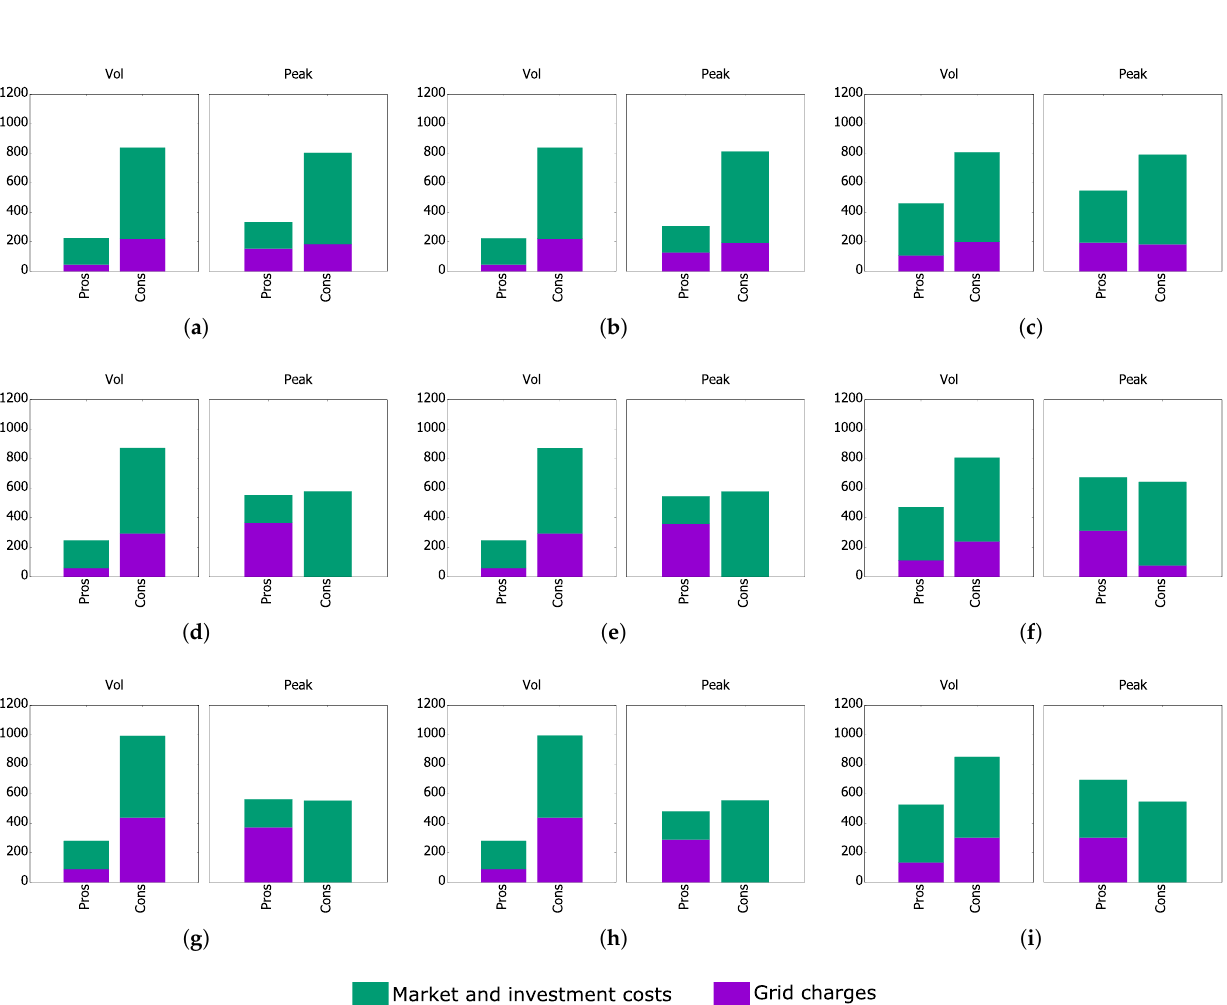
Figure 7. FCOEs for prosuming and consuming households [EUR/a] for different battery operation modes (1/2/3), network cost allocation schemes (vol/peak), and prosumer penetration ratios (25%, 50%, 75%). ( a ) Battery mode 1 at a 25% pros. penetration; ( b ) Battery mode 2 at a 25% pros. penetration; ( c ) Battery mode 3 at a 25% pros. penetration; ( d ) Battery mode 1 at a 50% pros. penetration; ( e ) Battery mode 2 at a 50% pros. penetration; ( f ) Battery mode 3 at a 50% pros. penetration; ( g ) Battery mode 1 at a 75% pros. penetration; ( h ) Battery mode 2 at a 75% pros. penetration; ( i ) Battery mode 3 at a 75% pros.